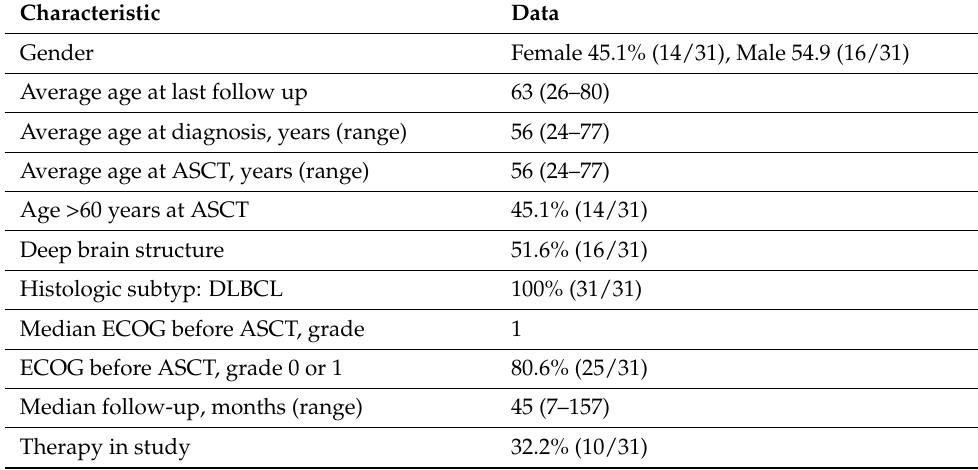
Table 2. Patient characteristics in the prospective evaluation cohort ( n =